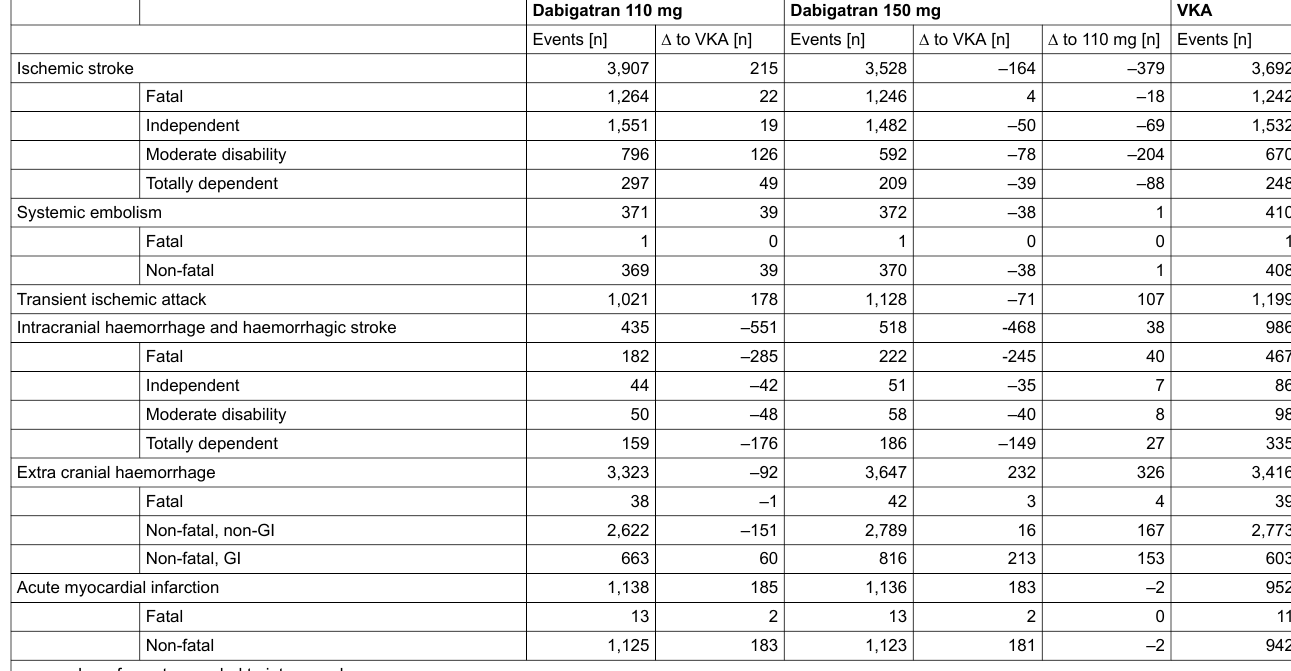
n = number of events rounded to integer